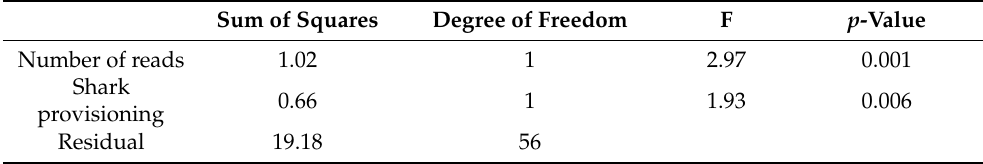
Table 3. The db-RDA results based on Bray–Curtis